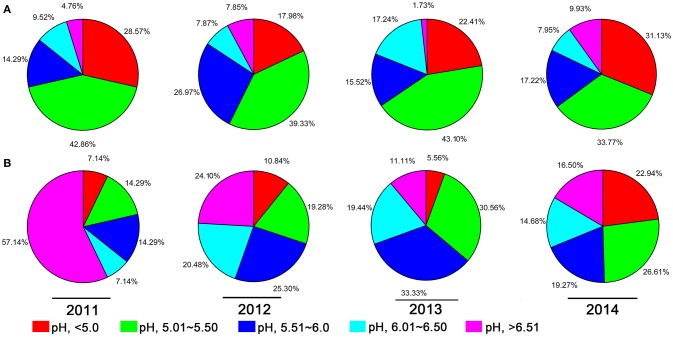
The proportion of different pH intervals in bacterial wilt infected soil (A) and non-infected soil (B) from 2011 to 2014. Five pH intervals (pH equal to or less than 5.0, pH from 5.01 to 5.50, pH from 5.51 to 6.00, pH from 6.01 to 6.50, and pH equal to or greater than 6.51) were used; pH intervals are indicated by color.